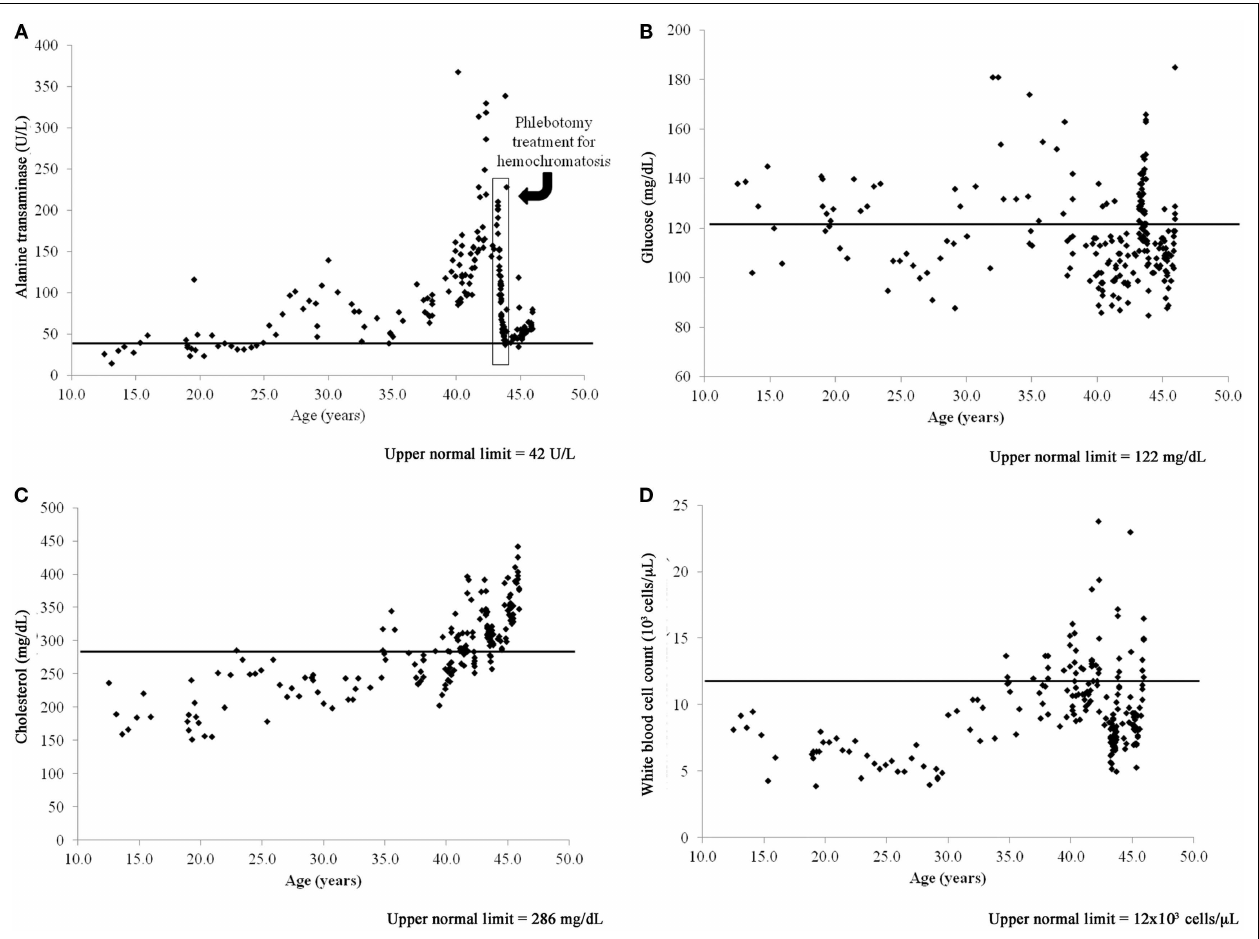
FIGURE 1 |Time series of blood value changes in the case bottlenose dolphin ( Tursiops truncatus ) with treated hepatic iron overload and chronic, postprandial hyperinsulinemia, and mild fatty liver disease: (A) alanine transaminase, (B) glucose, (C) cholesterol, and (D) white blood cell count .